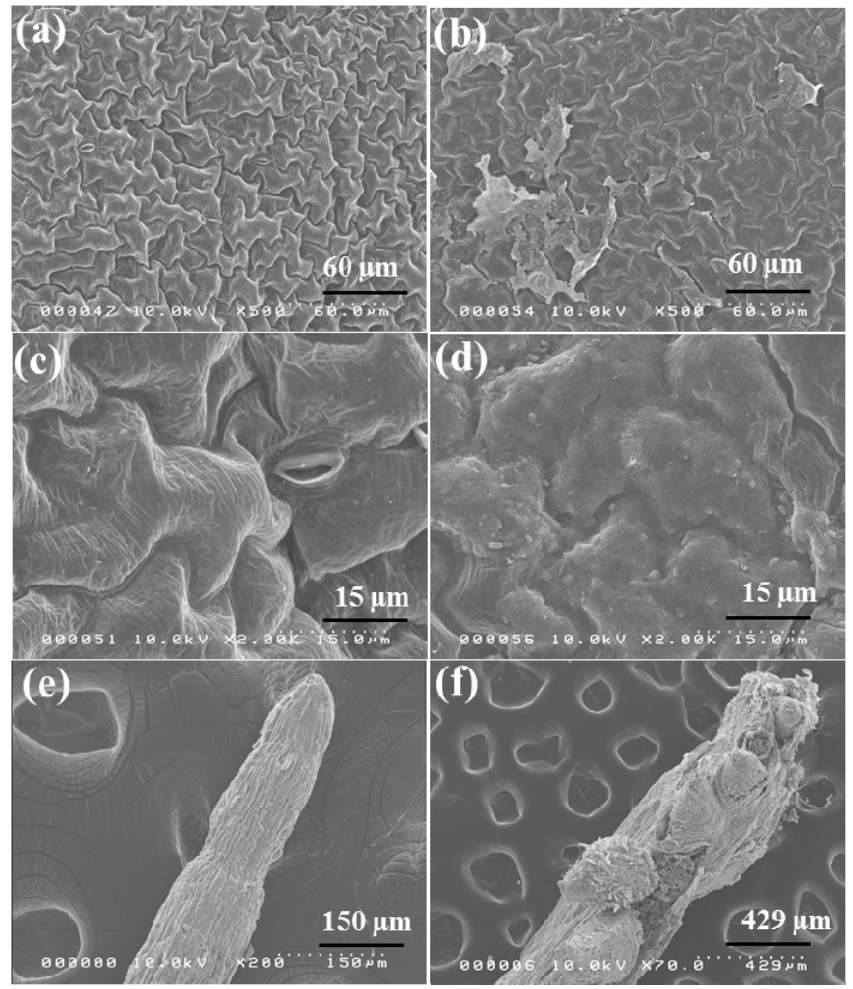
(treated). Image showing the morphology of control leaf ( a , c ) epidermis and MWNTs treated leaf ( b , d ) epidermis showing swelling epidermis. SEM observation of red spinach roots grown in vivo for 15 days in a medium containing Hoagland media only (control, e ) and supplemented with 1000 mg L − 1 MWNTs (treated, f ) showing deformed root cap and elongation zone and deformed epidermis. Bar: a and b , 60 µm; c and d , 15 µm; e , 150 µm; f , 429